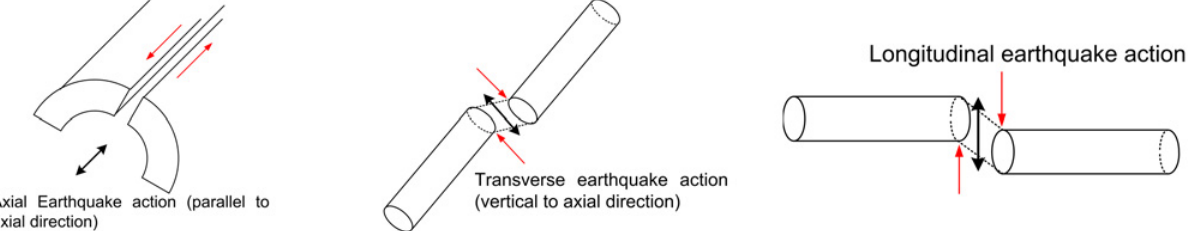
Fig 1. Pipeline failure mode. Pipeline failure under axial earthquake action (A), pipeline failure under transverse earthquake action (B) and pipeline failure under longitudinal earthquake action